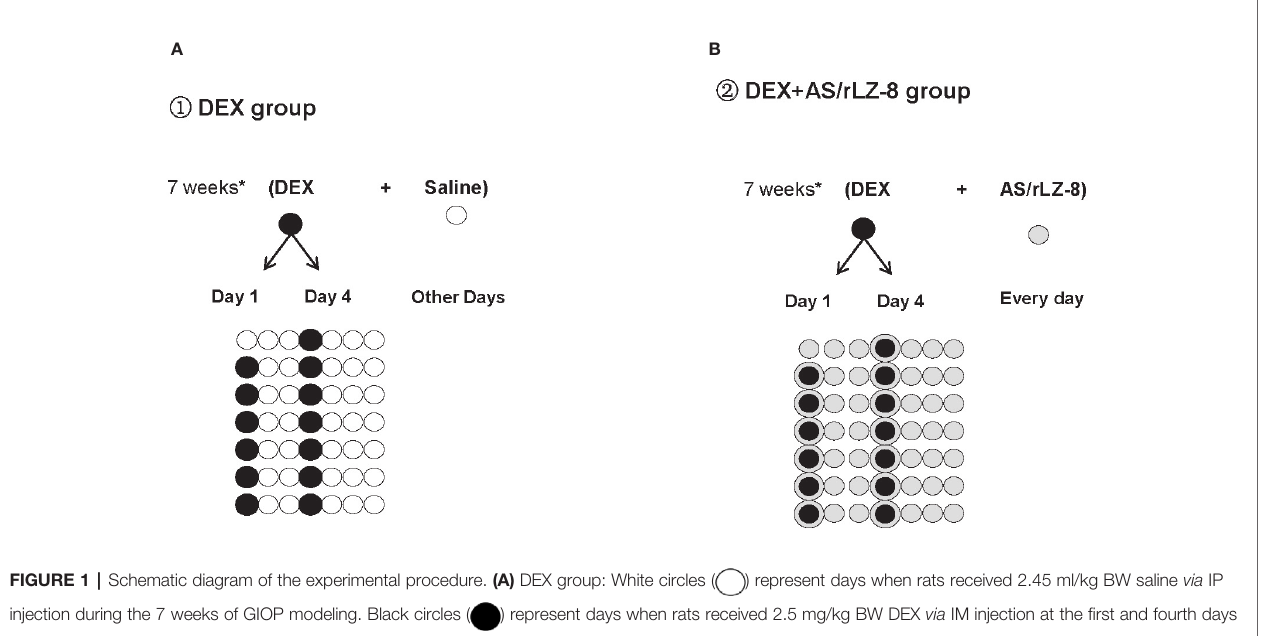
FIGURE 1 | Schematic diagram of the experimental procedure. (A) DEX group: White circles ( ) represent days when rats received 2.45 ml/kg BW saline via IP injection during the 7 weeks of GIOP modeling. Black circles ( ) represent days when rats received 2.5 mg/kg BW DEX via IM injection at the fi rst and fourth days of each week for 7 weeks. (B) DEX+AS/rLZ-8 group: Grey circles ( ) represent days when rats received 28.0 m g/kg, 56.0 m g/kg and112.0 m g/kg BW rLZ-8 via IP injection or 1 mg/kg BW AS via intragastric administration. Circled bullets ( ) represent days when rats received DEX as well as rLZ-8 or